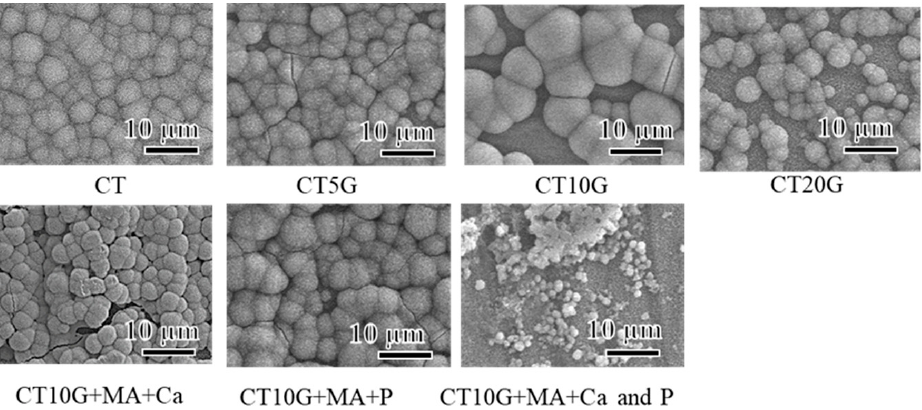
Figure 4. SEM images of surfaces of Ca–heat-treated Ti–6Al–4V alloy soaked in SBF for 7 days following dip coat treatment with various additives.